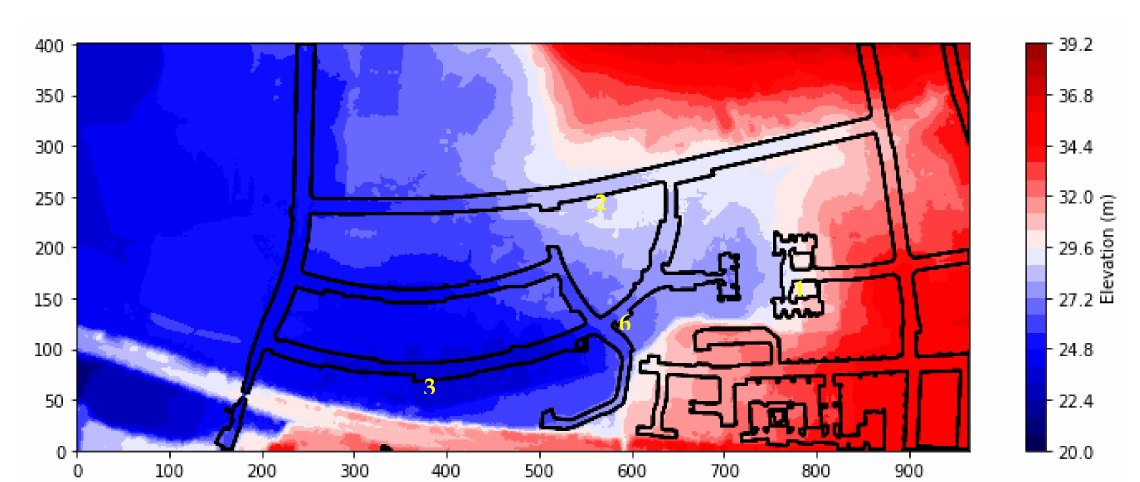
Figure 13. EAT8A domain in which the area inside the black solid lines is considered the